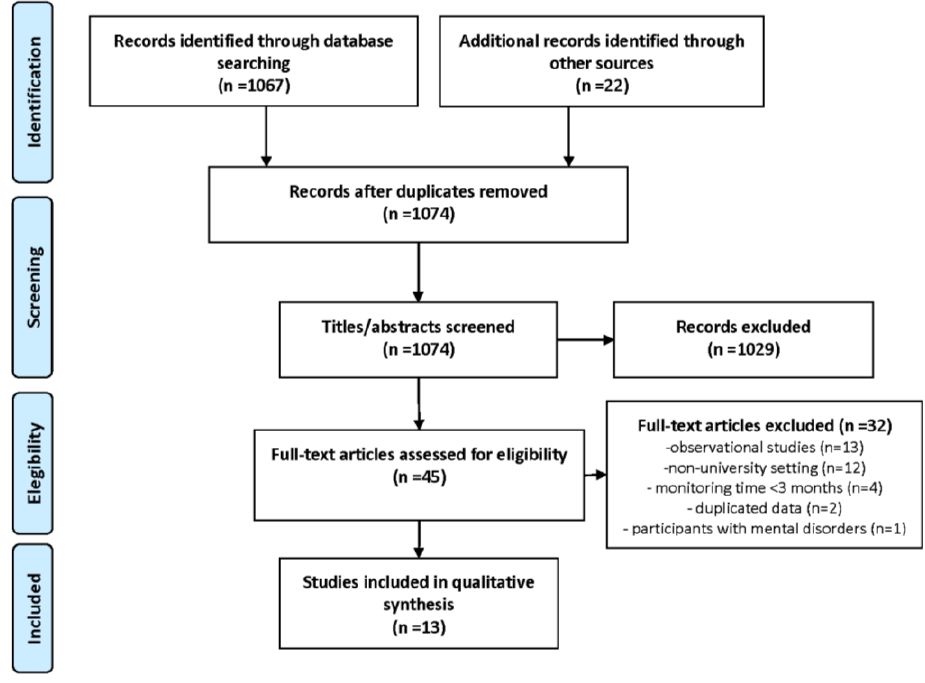
Figure 1. Flowchart of the study selection process.